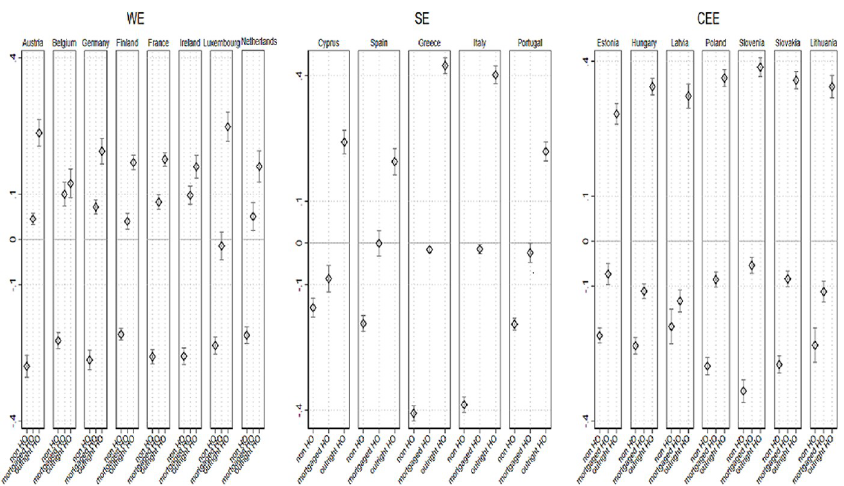
Fig 3. AME for pooled multinomial logistic regression predicting the difference in probability of housing tenure, by IWT and control variables.